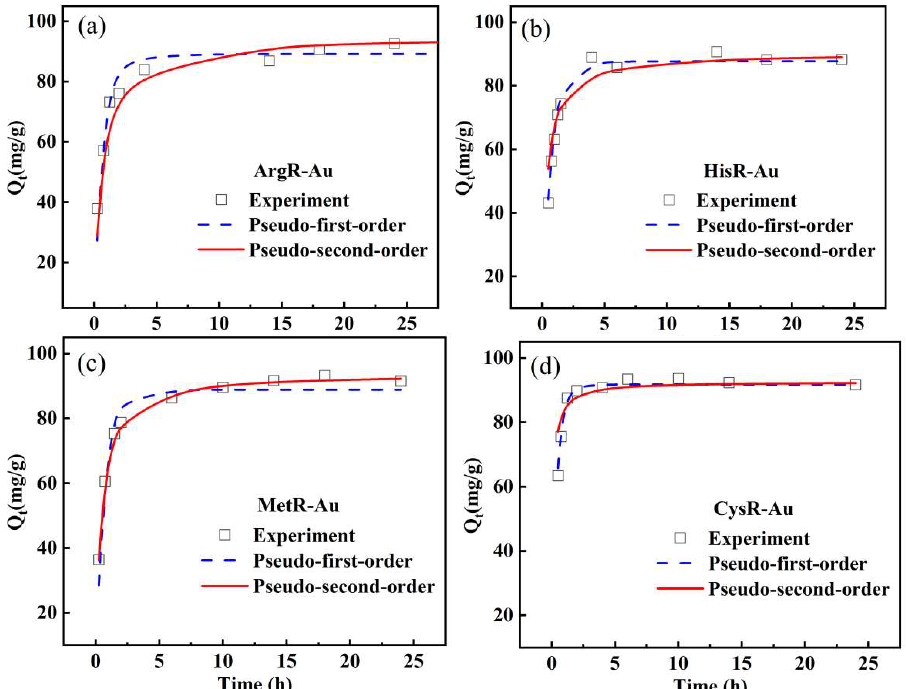
Figure 3. The adsorption kinetics of ArgR ( a ), HisR ( b ), MetR ( c ) and CysR ( d ) for Au(III) ions (C 0 = 100 mg/L, adsorbent mass = 10 mg, volume = 10 mL, pH = 2, T = 30 °C). The kinetic parameters obtained by fitting are listed in Table 1 (C 0 = 100 mg/L) and